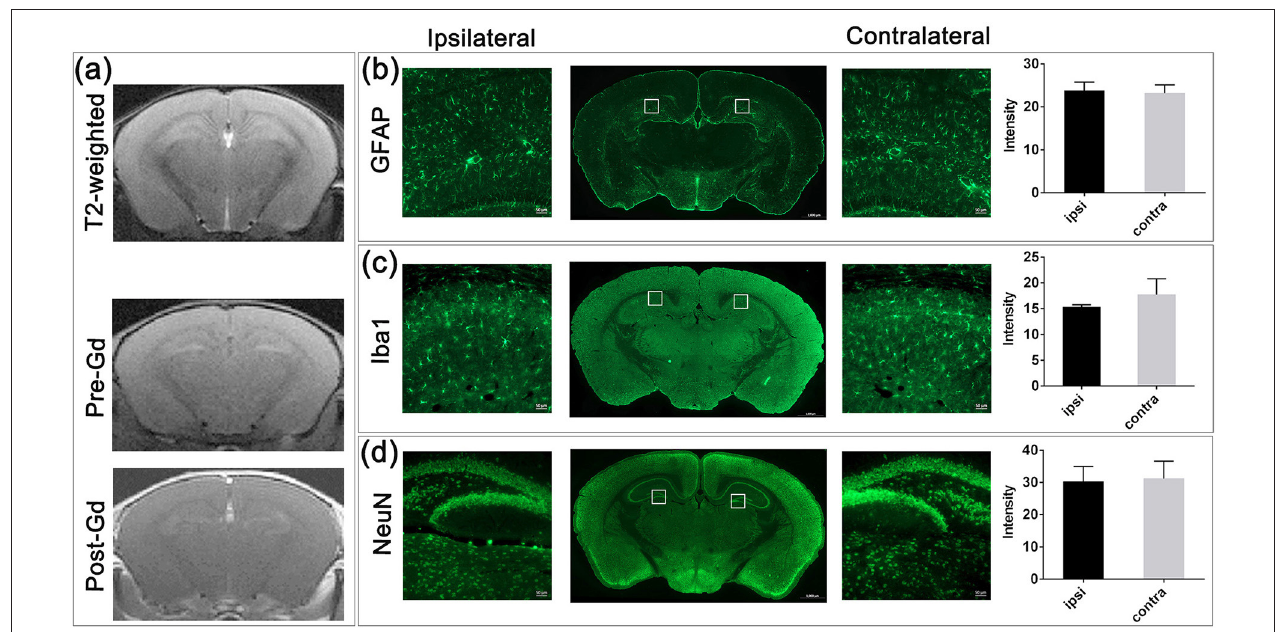
FIGURE 2 | MRI and histological assessment post-BBBO. (a) T2-weighted, pre-Gd, and post-Gd images 3 days after BBBO showed no sign of brain damage. No Gd-CE could be observed in the brain, suggesting that the BBB was resealed. Fluorescent staining of the BBBO region with GFAP (b) , Iba1 (c) , and NeuN (d) revealed comparable intensity between the ipsilateral and the contralateral hemisphere (2 ROIs/hemisphere as represented in lower magnification, n = 4, mean ± SD) indicating no inflammation and no neuronal loss after BBBO.